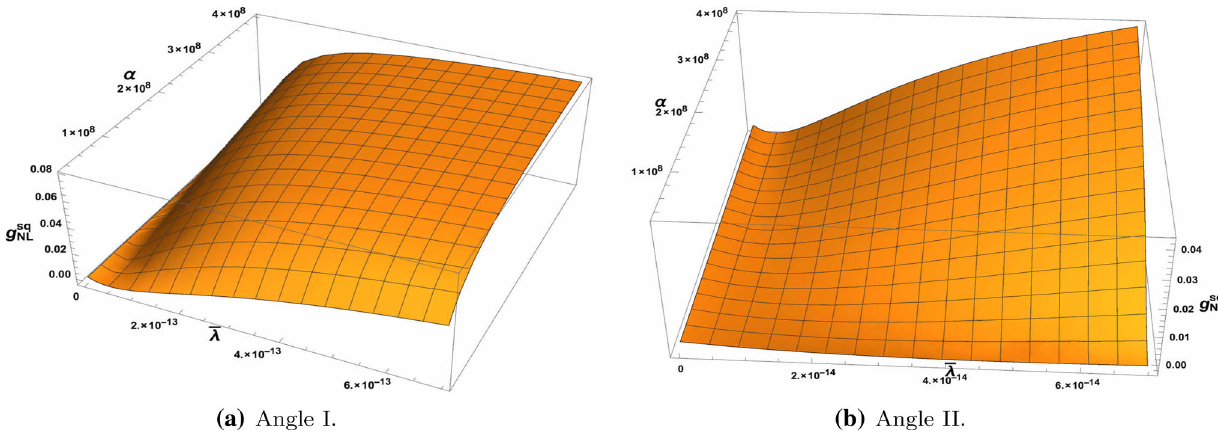
Fig. 33 Representative 3D diagram for equilateral non-Gaussian three point amplitude vs. the model parameters α and ¯ λ for N cmb = 60 in two different angular